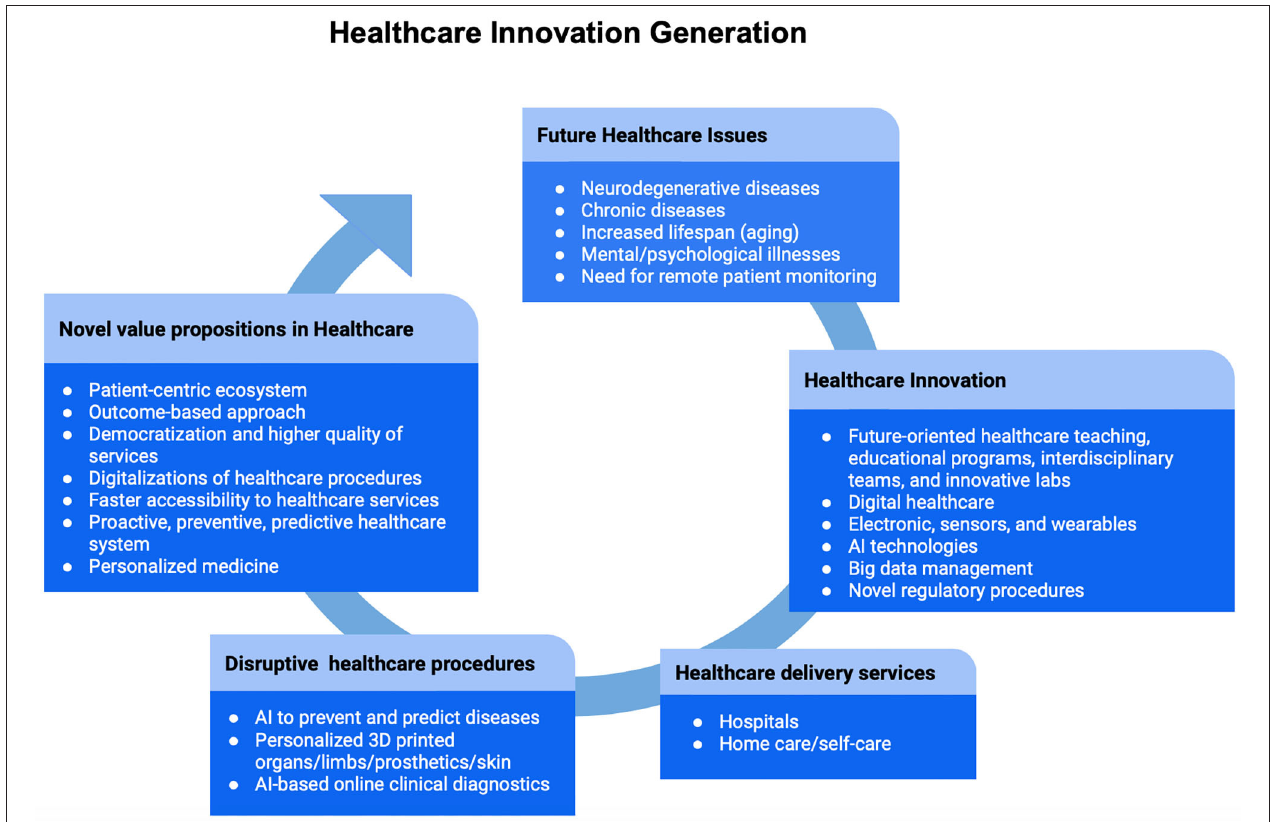
FIGURE 5 | Healthcare innovation generation. A summary of the main results is represented in the diagram. Future healthcare issues will be mostly determined by increased neurodegenerative and chronic diseases, followed by demographic changes characterized by the aging population, mental/psychological illnesses, and need for remote patient monitoring. In response to these challenges, the entire healthcare system needs to embrace innovation. Therefore, the process of innovation will be characterized by a revised education to prepare future healthcare professionals, digital services, novel regulatory procedures, a better management of big data, and the implementation of advanced medical technologies. In particular, hospitals and home care/self-care are the two main places where innovative healthcare delivery services will take place. Furthermore, the implementation of disruptive technologies will empower healthcare with preventive, predictive, and personalized procedures. Generating novel value propositions means the promotion of a proactive system, focused on health and prevention. With a patient-centric and outcome-based approach, followed by the democratization and faster accessibility of care services through digitalization, healthcare will be capable of embracing innovation while facing the rapid changes brought by the 21 st